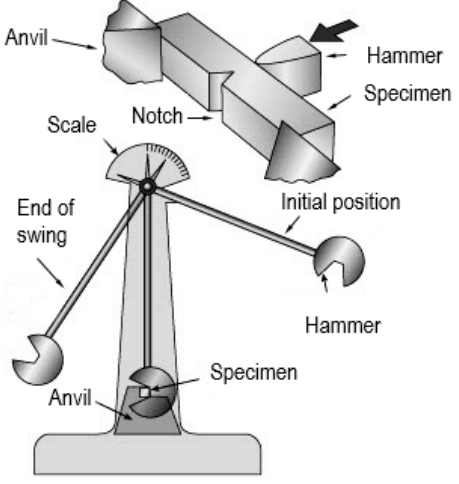
Figure 3. Principle of executing Charpy impact strength test.